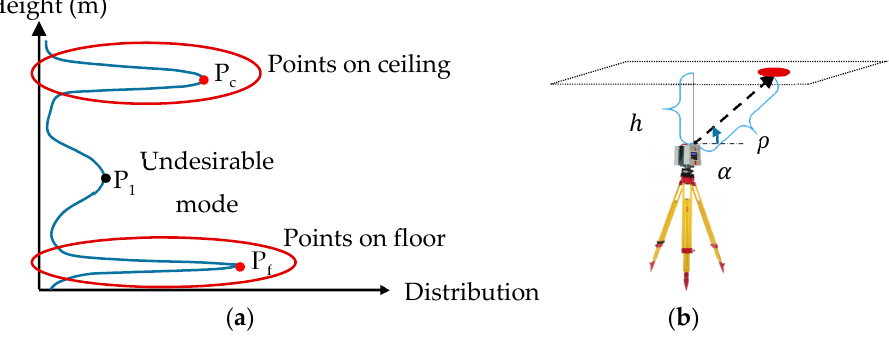
Figure 6. ( a ) Expected point height distribution; ( b ) schematic representation of the raw measurements of a point on a horizontal plane.